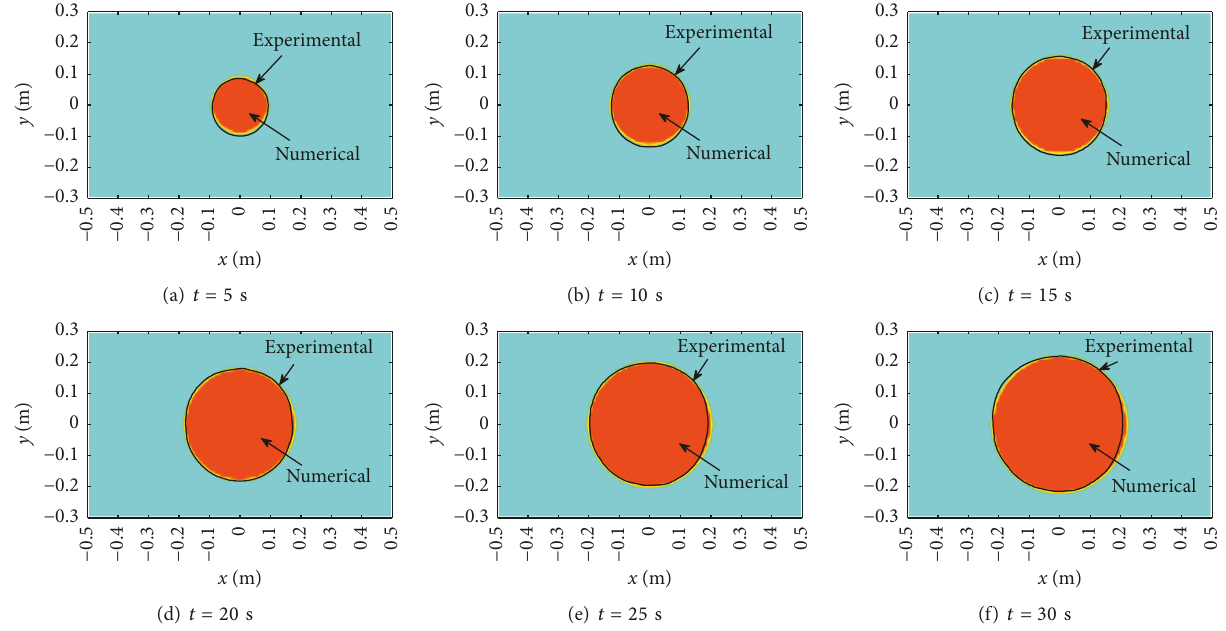
Figure 19: Comparison of the grout diffusion region and morphology between numerical and experimental